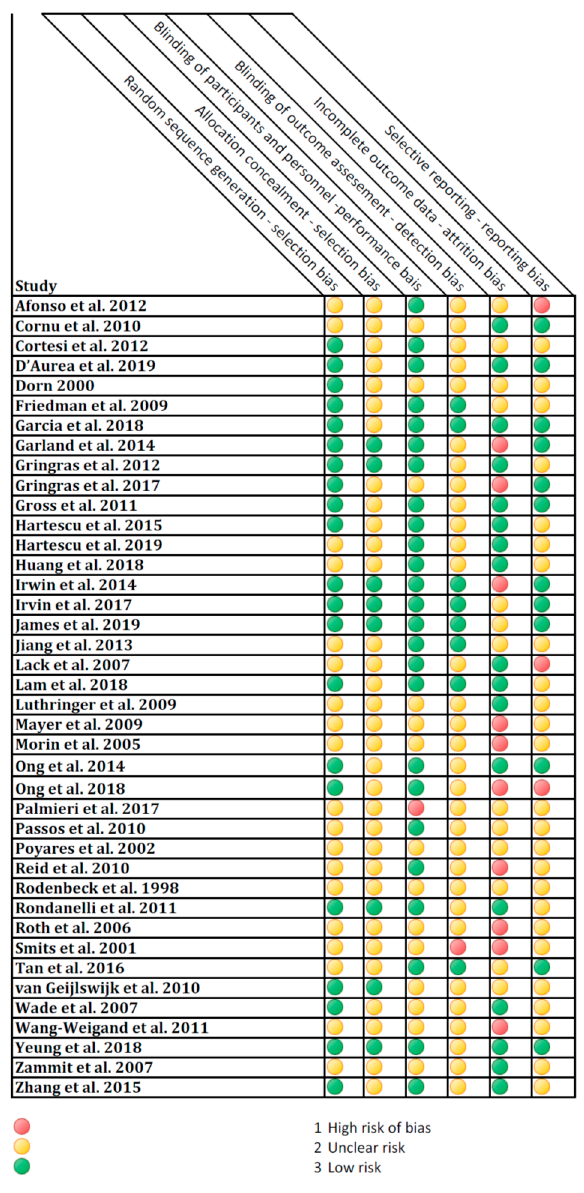
Figure 2. Risk of bias.